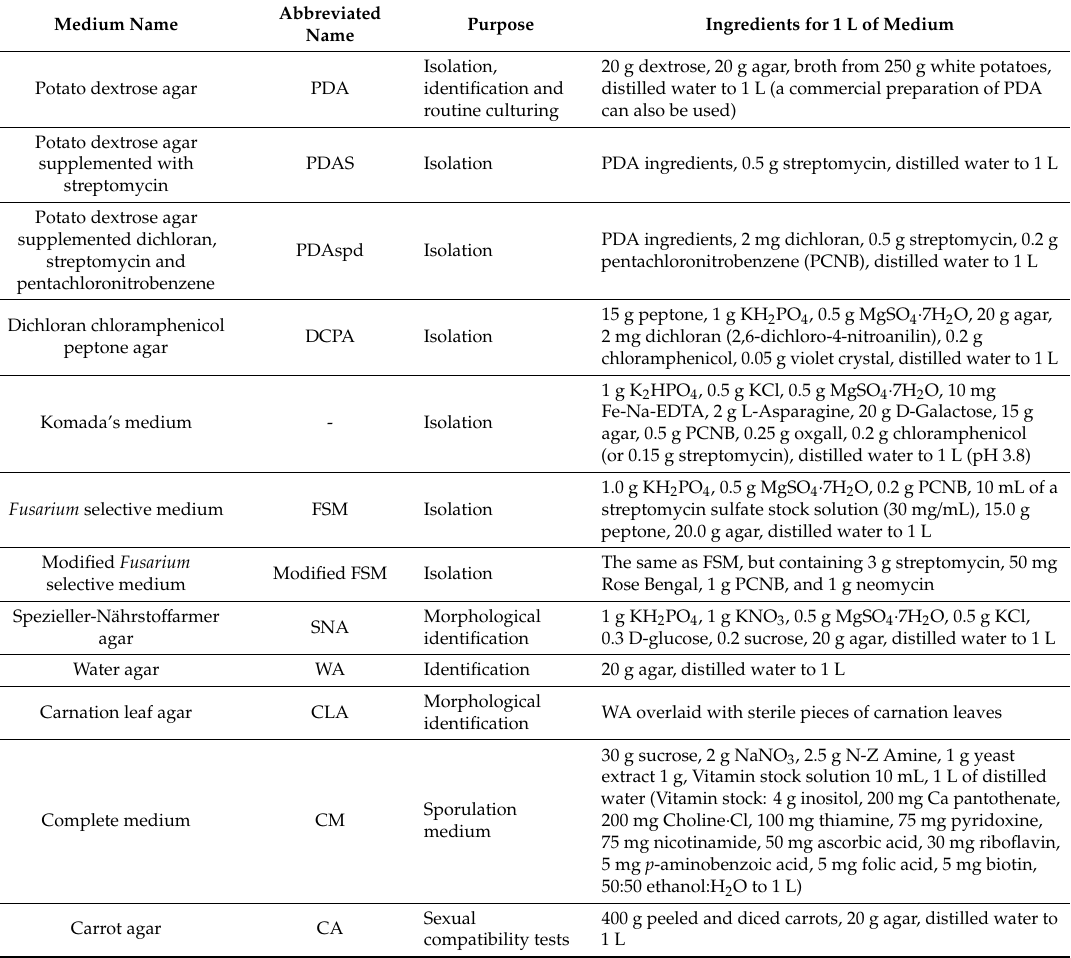
Table 5. Composition of the various growth media used for the isolation and identification of the pitch canker fungus, Fusarium circinatum . See the text for